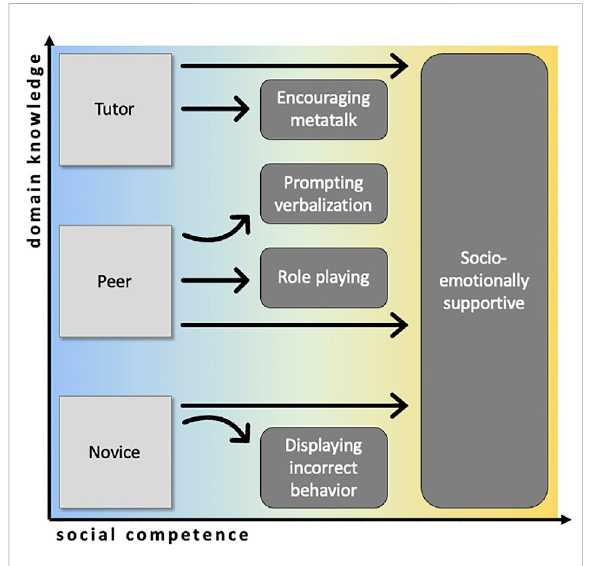
FIGURE 1 Summary of the various social/dialogical roles presented in this review. On the left, the established roles differ with respect to the domain knowledge. They can be further speci fi ed in the innovative roles that differ in terms of social